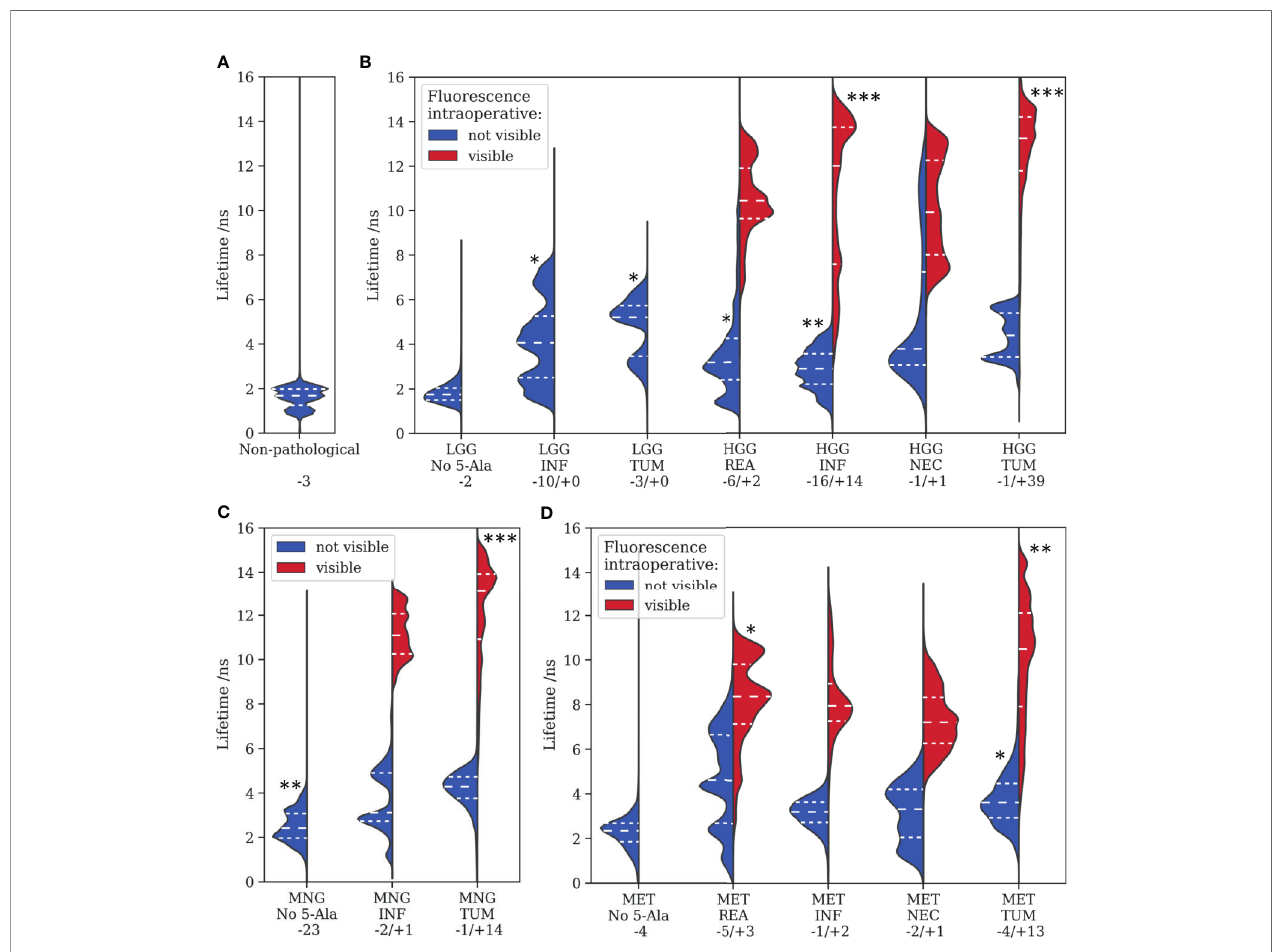
FIGURE 4 | Fluorescence lifetimes measured for various tumor entities are visualized with violin plots, where the dashed lines represent the median, 0.25 and 0.75 quartiles. (A) non-pathological tissue, (B) low- and high-grade gliomas, (C) meningiomas, and (D) metastasis. Tissue was further categorized into reactive (REA), in fi ltration zones (INF), necrotic regions (NEC), and core tumor areas (TUM) according to the histopathological workup. Statistical levels of signi fi cant difference to (A) of each subgroup are indicated with asterisks (*<0.05, **<0.01, ***<0.005). Numbers after a “– or “ + ” refer to the amount of samples without or with visible intraoperative fl uorescence,